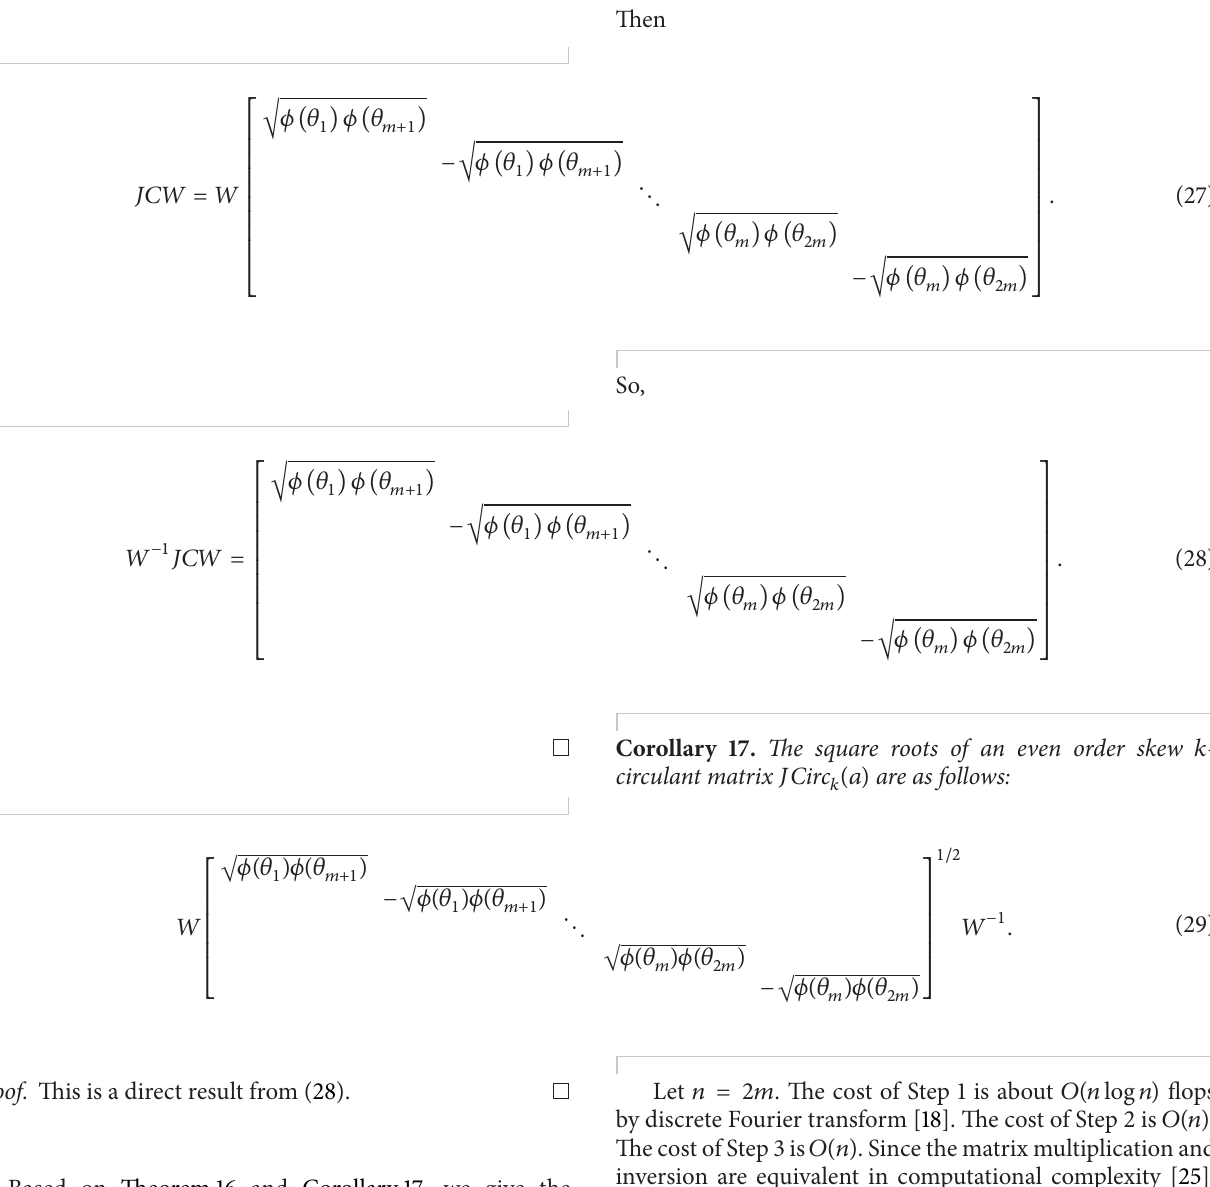
Algorithm 18. Compute a principal square root of a skew 𝑘 - circulant matrix 𝐴 ∈ C 2𝑚×2𝑚